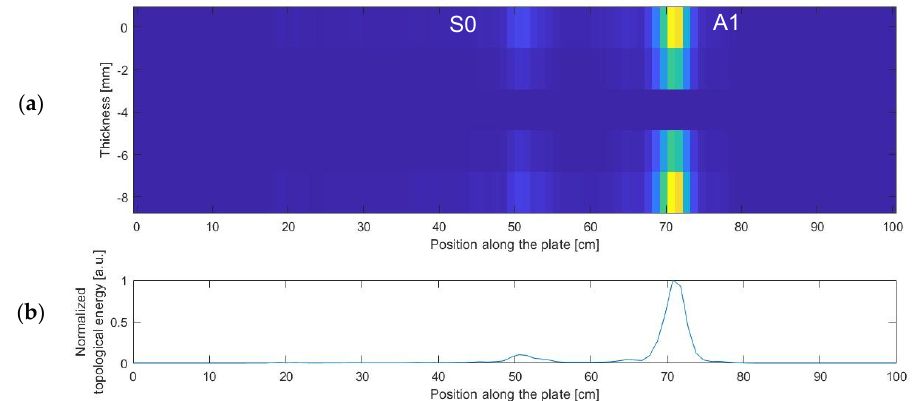
Figure 13. ( a ) Topological image in the region of interest of the simulated plate; ( b ) Normalized sum of the topological energy at each position along the plate.